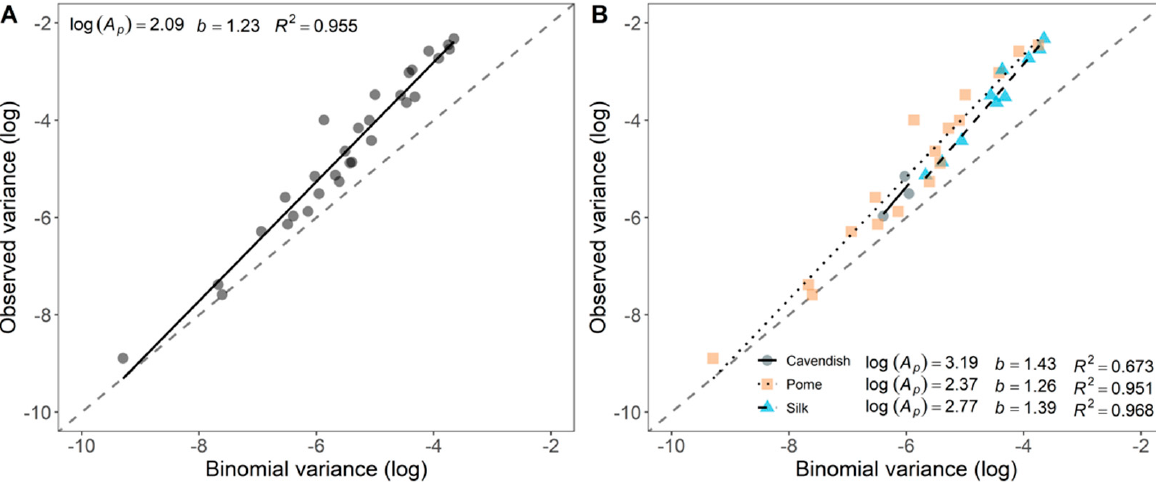
(cid:0) (cid:1) s 2 ) and the logarithm of theoretical variance obs